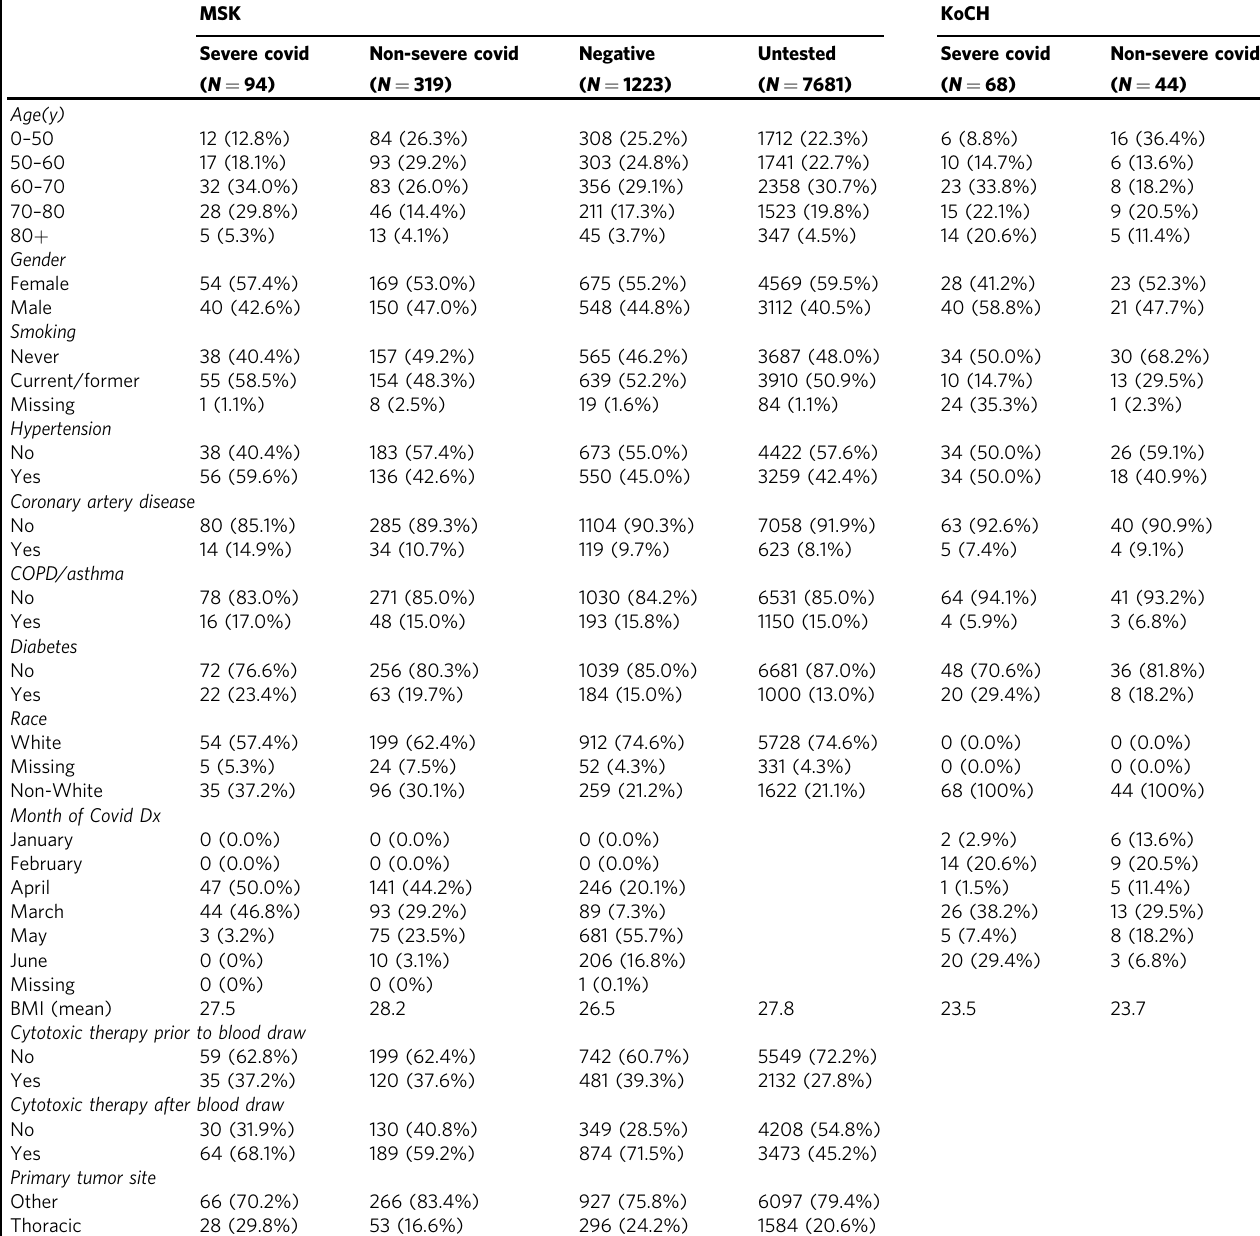
Table 1 Characteristics of study